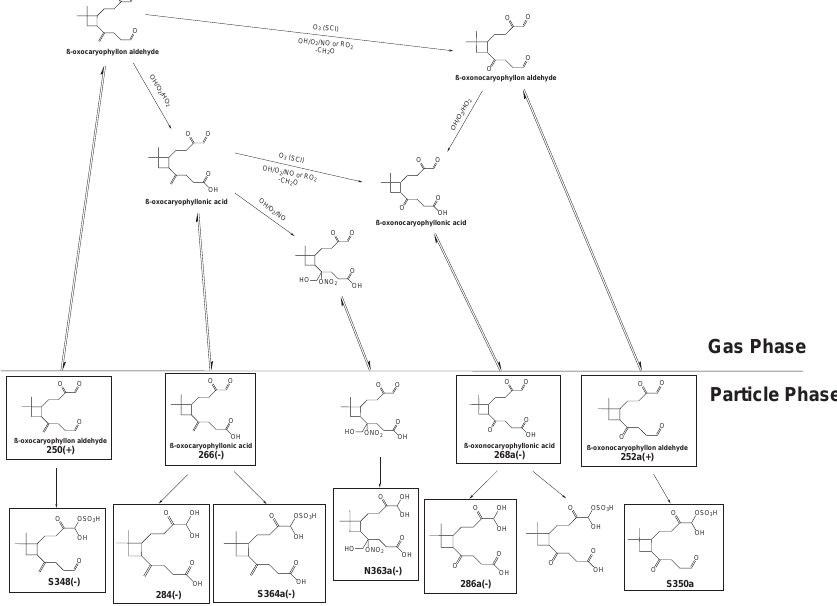
Scheme 4. Proposed reaction pathways of β -oxocaryophyllon aldehyde, leading to compounds detected by ESI in the particle phase. Forma- tion mechanism of β -oxocaryophyllon aldehyde from the ozonolysis of β -caryophyllene (Winterhalter et al., 2009). β -14-oxocaryophyllon aldehyde is chosen as illustration. Boxes indicate compounds detected by ESI in the particle phase. One possible structural isomer is shown. SCI is the stabilized Criegee intermediates